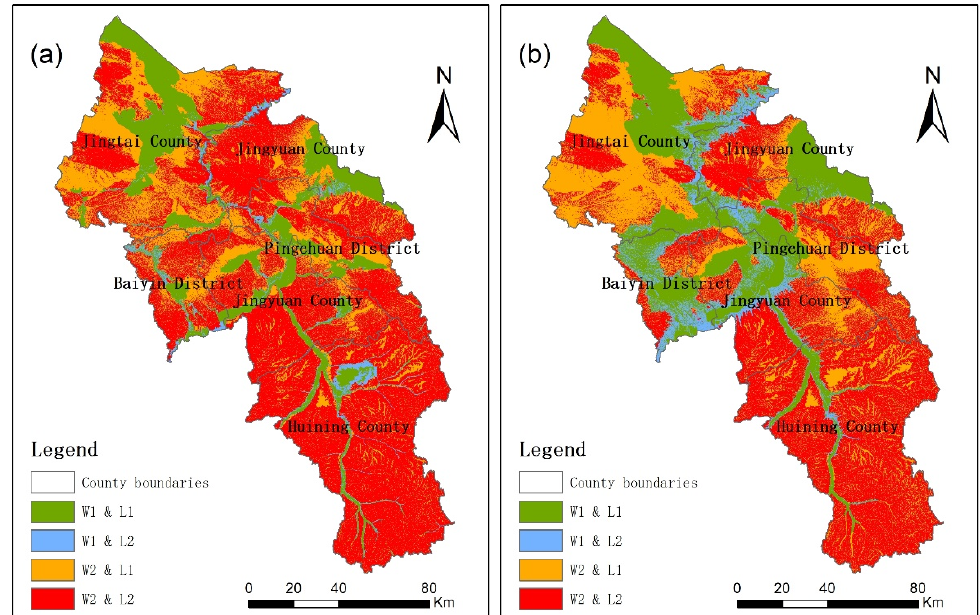
Figure 8. ( a ) Coupling of water and land resources suitable grades for agricultural production; ( b ) Coupling of water and land resources suitable grades for urban construction. W1: water resources suitable area and relatively suitable area; W2: water resources less suitable area and unsuitable area; L1: land resources suitable area and relatively suitable area; L2: land resources moderately suitable area, less suitable area, and unsuitable